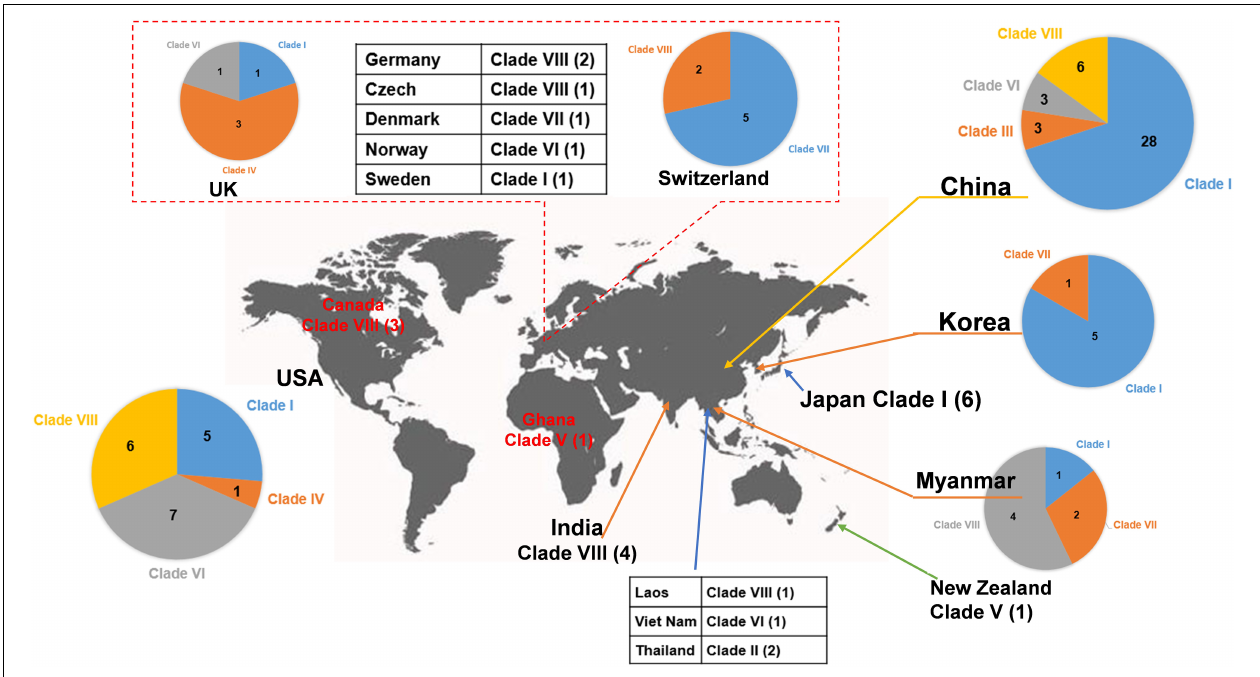
FIGURE 4 | Worldwide distribution of bla NDM -positive plasmids of E. coli . The geographical distribution of the eight clades (Clade I–Clade VIII) from the bla NDM -positive plasmids of E. coli was calculated and displayed by pie